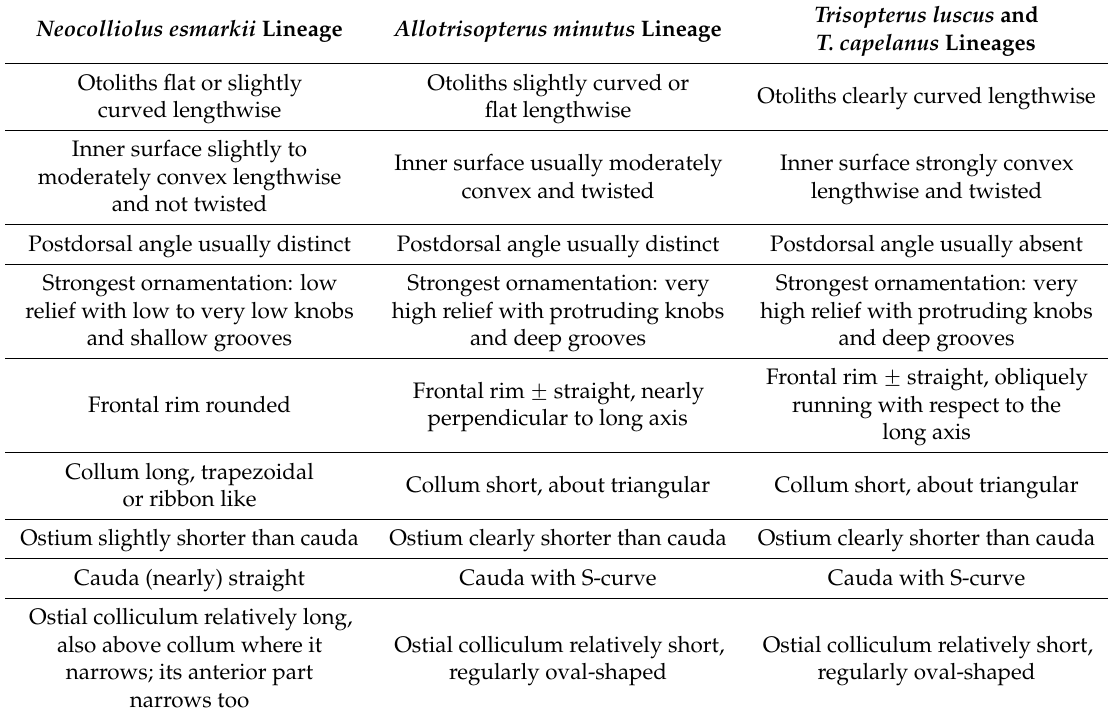
Table 3. Differences and similarities between otoliths of Neocolliolus , Allotrisopterus and Trisopterus . Neocolliolus esmarkii